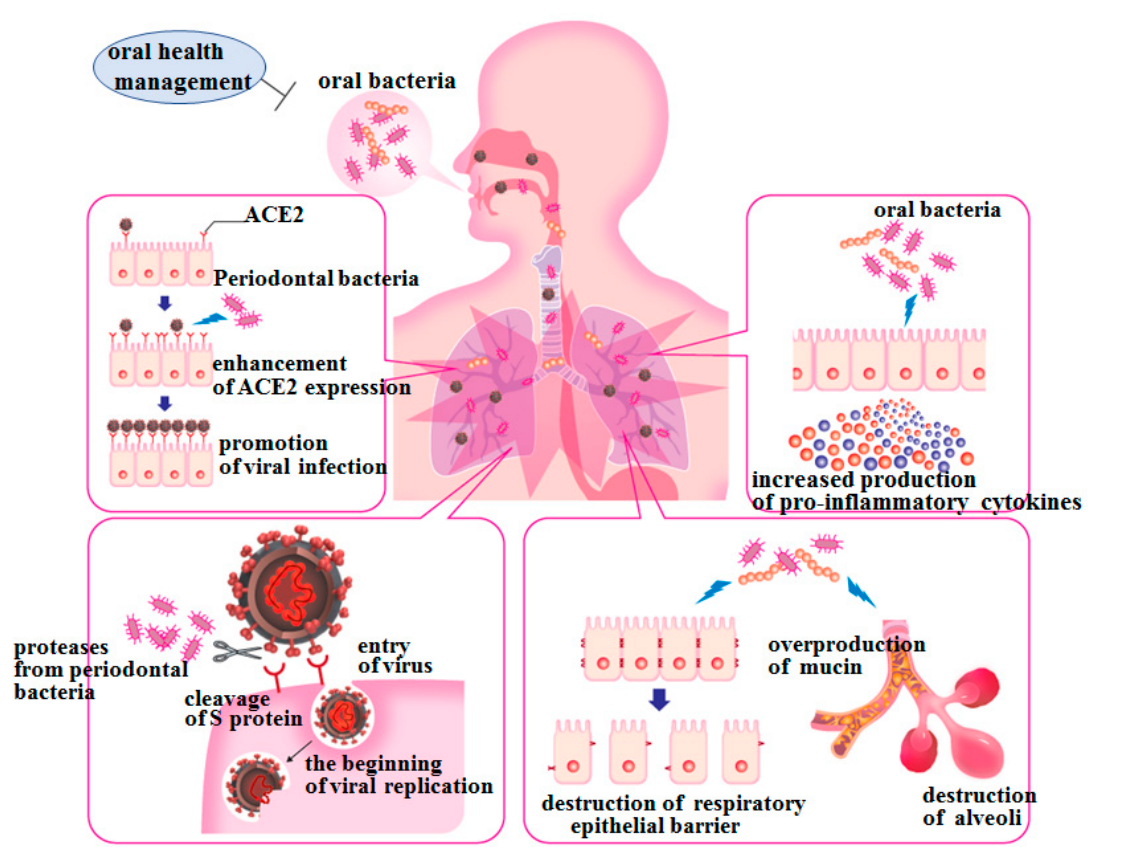
Figure 6. Exacerbation of lower respiratory tract inflammation by stimulation with oral bacteria viewed from the oral cavity-lower respiratory tract axis. The elderly are prone to aspirate oral bacteria along with saliva. In addition, in the current dental situation, the longer the SARS-CoV-2 epidemic continues, the less opportunity there is for professional oral hygiene management, resulting in poor oral hygiene for the subjects with oral health management needs; this is also exacerbated on cases of hospitalization due to COVID-19 attributable to a general shortage of dental professionals in large hospitals. Aspiration of periodontal pathogens and other oral bacteria in patients with COVID-19 induces the expression of ACE2 on the lower respiratory epithelia and the production of proinflammatory cytokines in the lower respiratory tract; this may lead to a “negative spiral” of proinflammatory phenomena in the lower respiratory tract caused by the collaboration between viruses and bacteria. In addition, oral bacteria may induce excessive production of mucin in the lower respiratory tract, resulting in decreased respiratory function, and they may also cause destruction of the epithelial barrier in the alveoli and bronchi. Therefore, oral health management may prevent the aggravation of COVID-19 by suppressing the abovementioned harmful phenomena in patients with